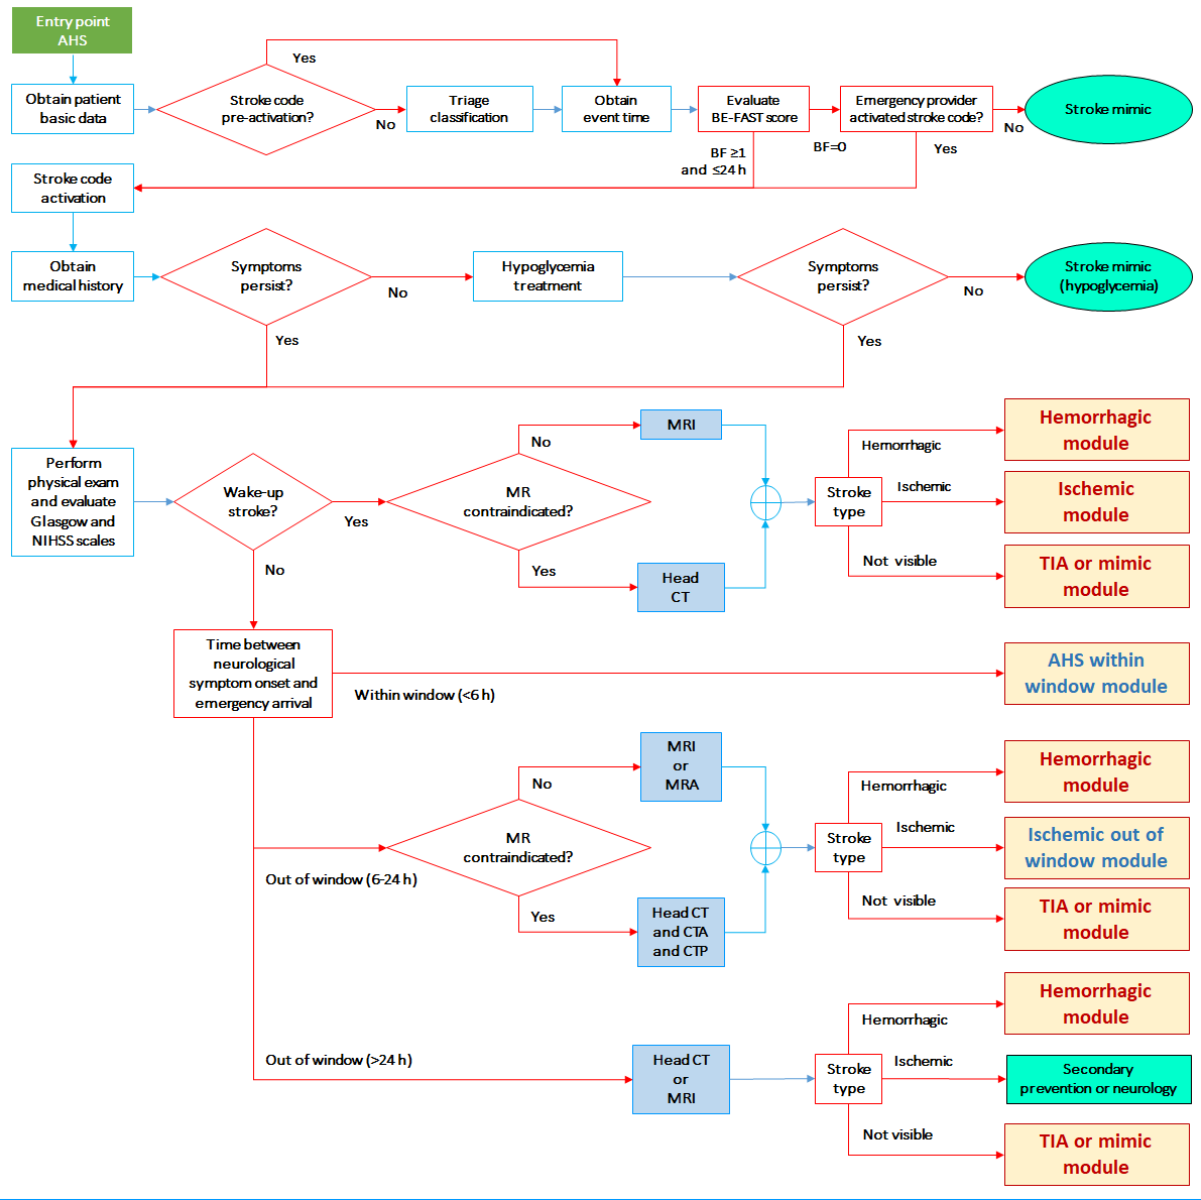
Figure 5. Workflow for the advanced health care setting (AHS). CT: computed tomography; CTA: computed tomography angiography; CTP: computed tomography perfusion; Glasgow: Glasgow Coma Scale; MR: magnetic resonance; MRA: magnetic resonance angiography; MRI: magnetic resonance imaging; NIHSS: National Institutes of Health Stroke Scale; TIA: transient ischemic